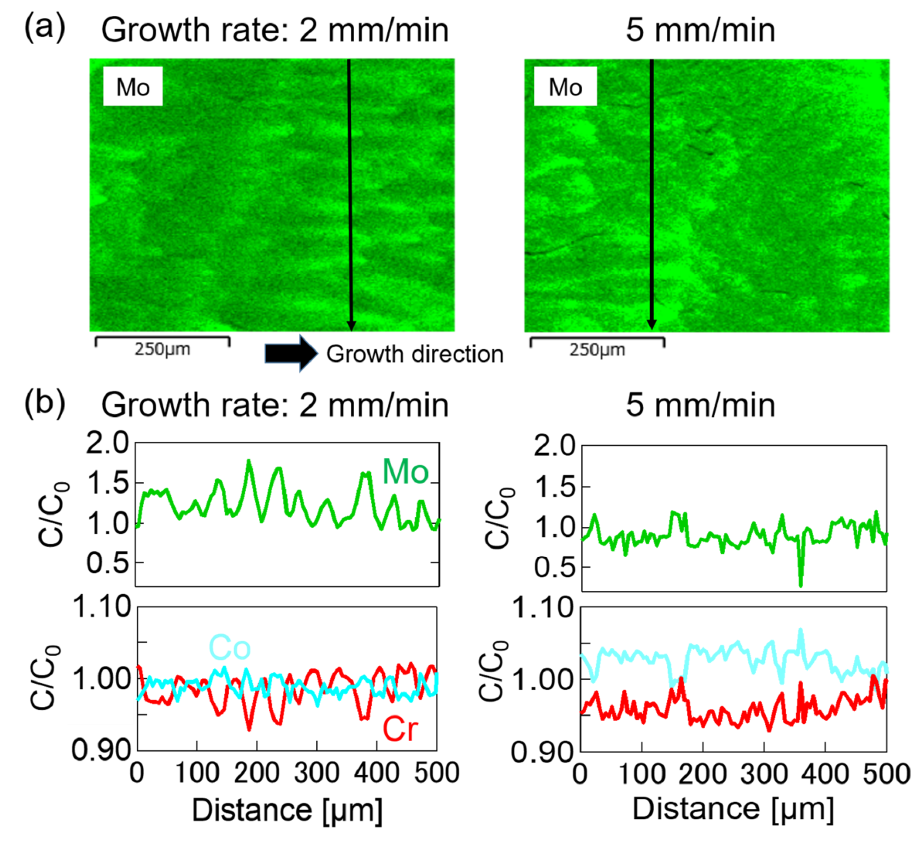
Figure 4. Chemical composition analyses on the treated surfaces of the Co-Cr-Mo fibers fabricated at 2 and 5 mm/min growth rates by an energy-dispersive X-ray spectrometer (EDX). ( a ) Element mappings of Mo along the growth direction. ( b ) Element distributions of Co, Cr, and Mo along the black arrow in the element mappings of Mo.